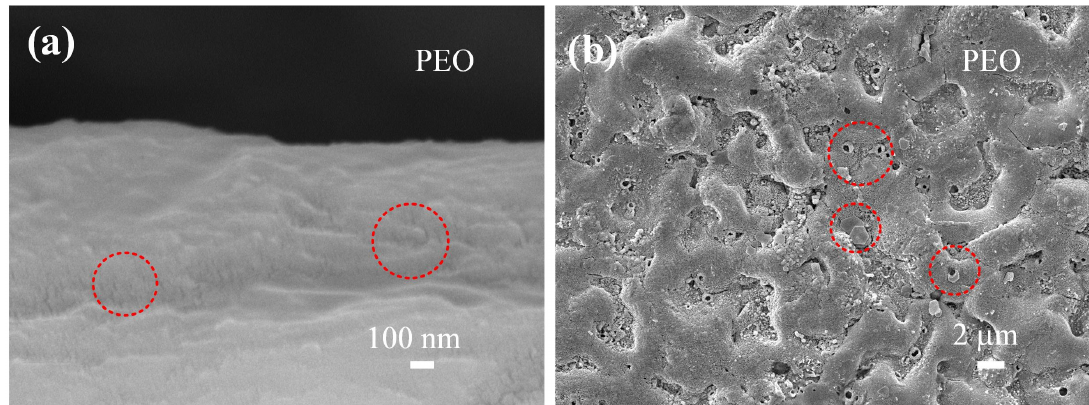
Figure 6. Morphology of the PEO coating with pre-anodized oxide. The SEM images of ( a ) cross-sectional view and ( b ) top view of the PEO coating, which is preceded by an AAO layer prepared at 200 V ( + ) / 40 V ( − ). Large circles mark the electrical discharge